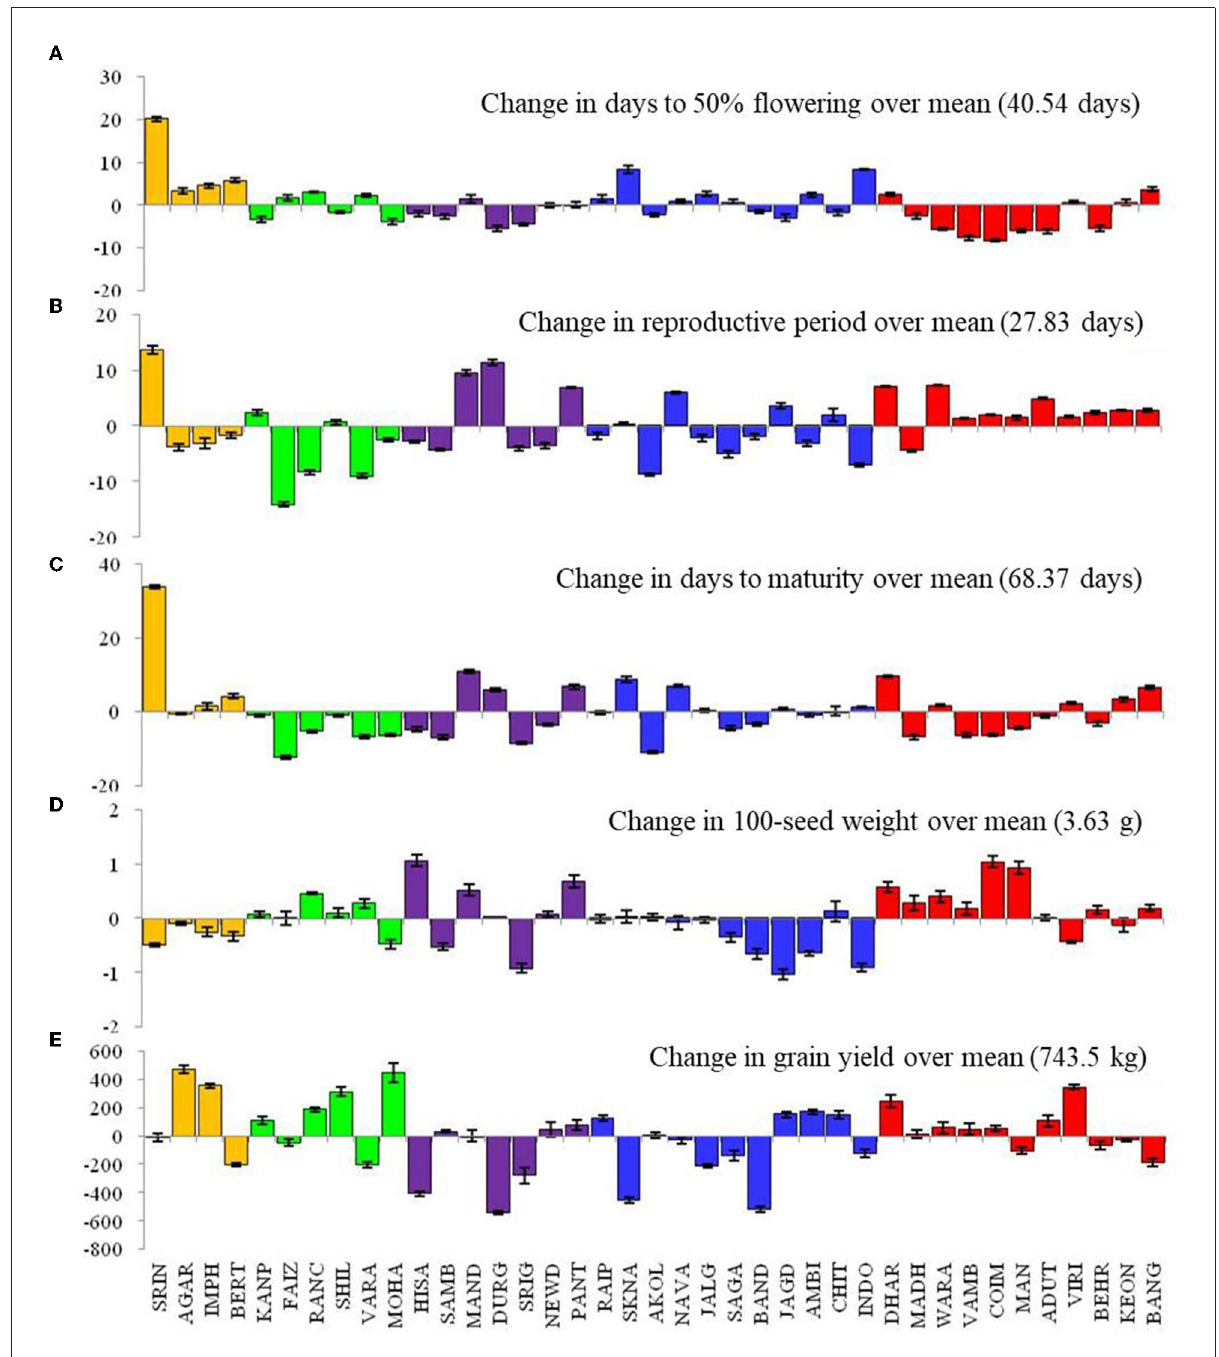
The results revealed that environment-induced variations in DTF and RP had a non-significant influence on the yield of mungbean genotypes except for the cultivar PM 14-11 (Table 1). Particular to the genotype PM 14-11, grain yield was